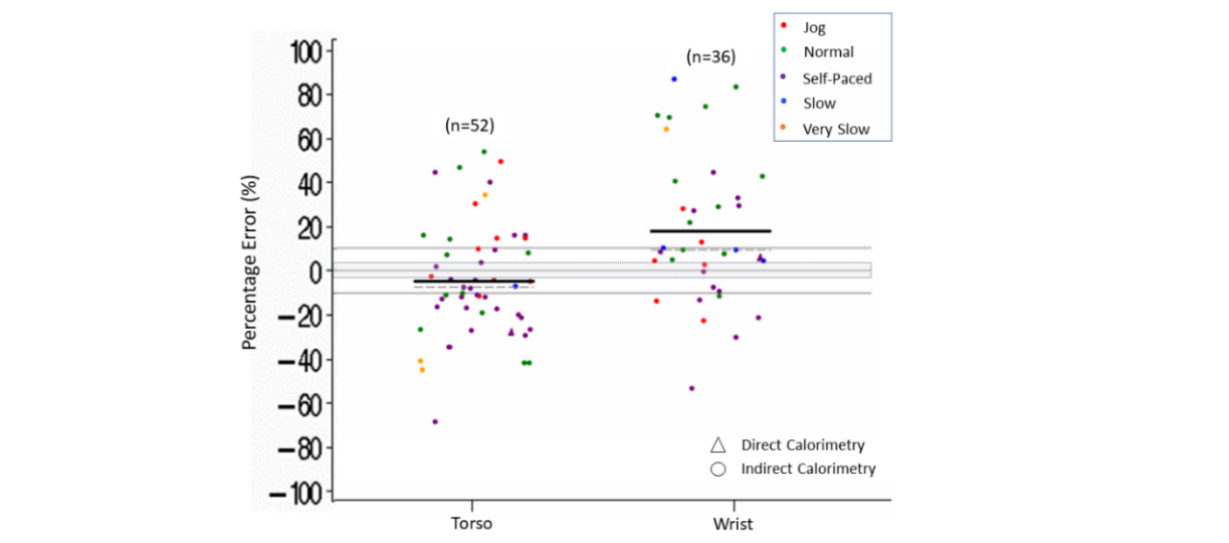
Figure 7. Energy expenditure percentage error in controlled settings. Body placement (torso, wrist) by speed (jog, normal, self-paced, slow, very slow). Dark lines indicate mean (horizontal). Dashed lines indicate median (horizontal). Triangles indicate measurement by direct calorimetry. Gray shading indicates ±3% measurement error.